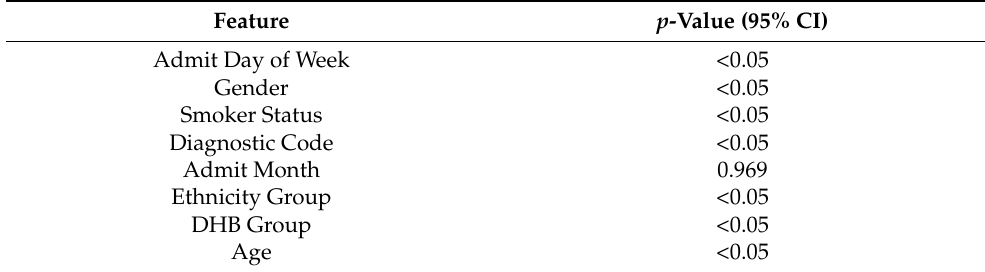
Table A1. Correlation of features and LOS